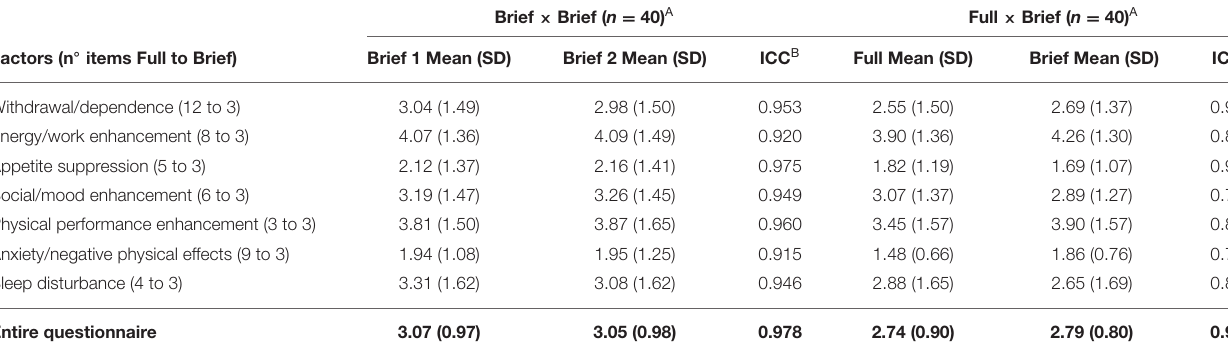
TABLE 2 | Mean (SD) of Caffeine Expectancy Questionnaire in Brazil (CaffEQ-BR) full and brief scores and measure of